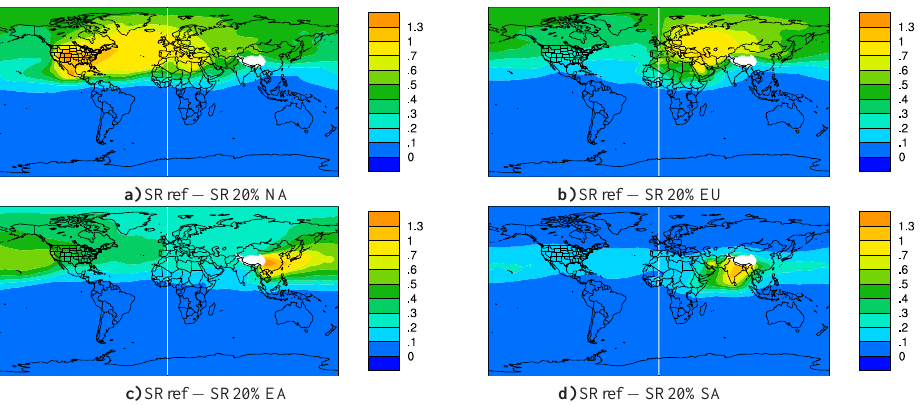
Fig. 1: Effects of emission reductions (2001) in North America (a), Europe (b), East Asia (c), and South Asia (d) on ozone (ppb) in the lower free troposphere (750 hPa) averaged over one year (2001) calculated with the model ensemble of the first 7 models listed in Table 1. The zero contribution over the Himalayas is caused by the 750hPa surface being below the surface here.